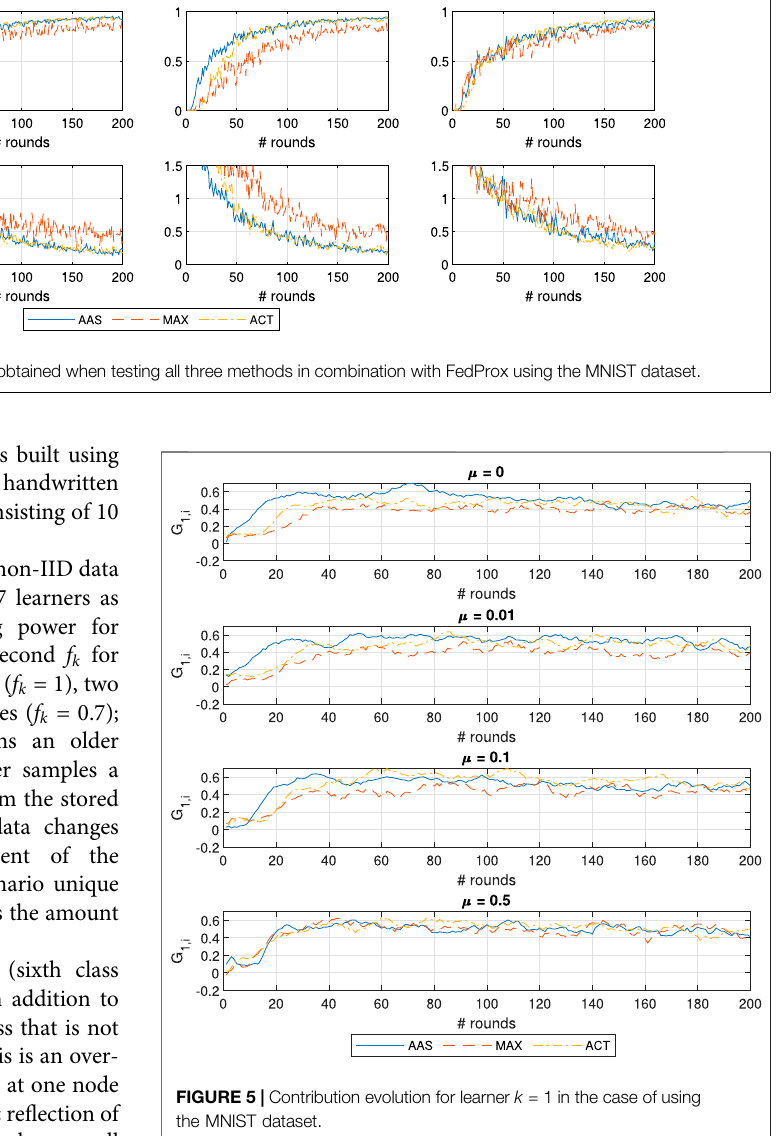
more detail, the CNN has only one 3 × 3 layer of 64 channels using the recti fi er linear unit (ReLU), that goes to a 2 × 2 polling layer. A dense, fully connected neural network (NN) layer of 64